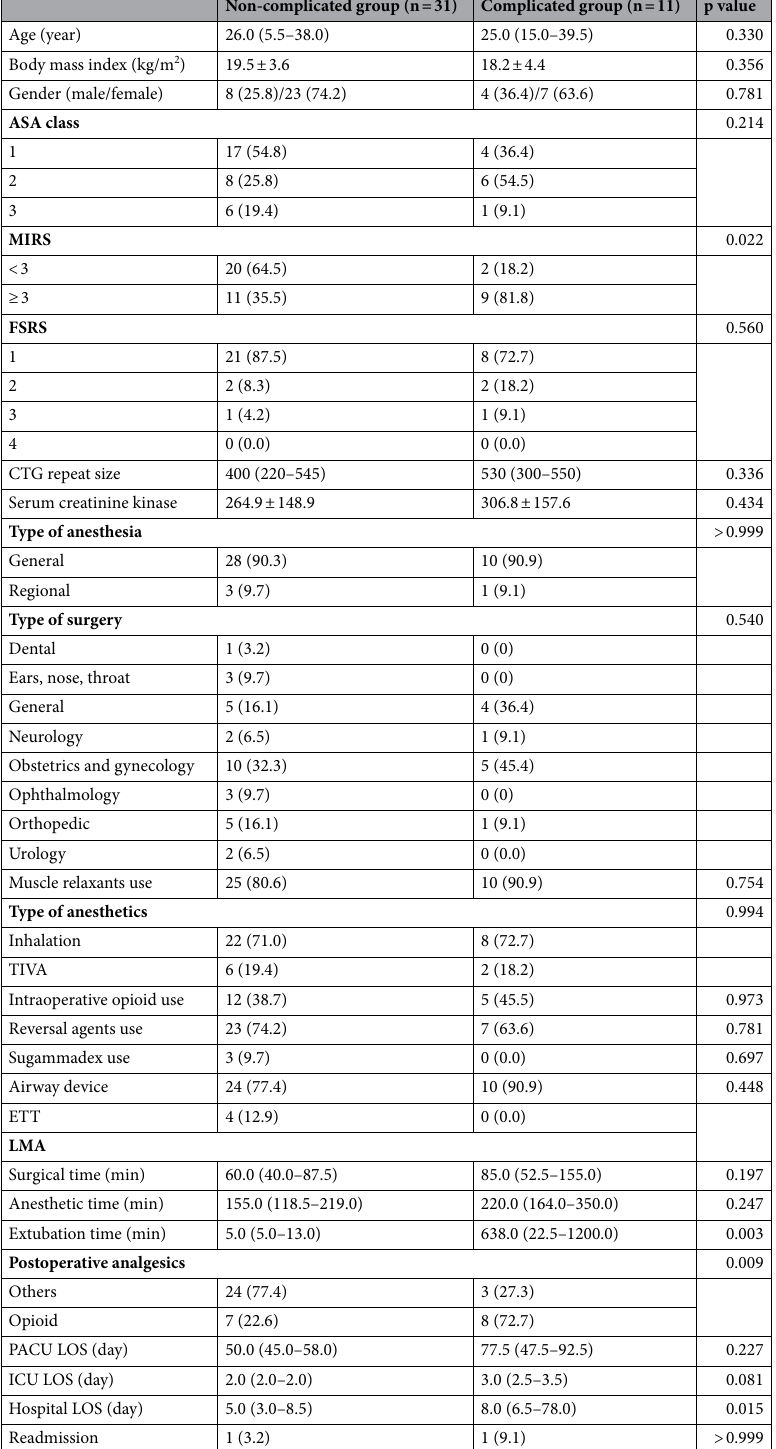
Table 2. Comparison of non-complicated group and complicated group during perioperative period. Data are expressed as mean (standard deviation), number (%), or median (interquartile range). MIRS